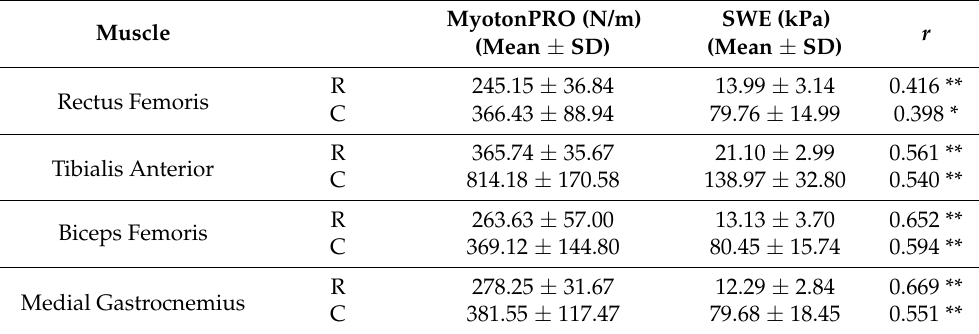
Table 2. Correlation coefficients of muscle stiffness values for MyotonPRO and shear wave elastogra- phy (SWE) at rest and during active voluntary contraction ( N = 40).